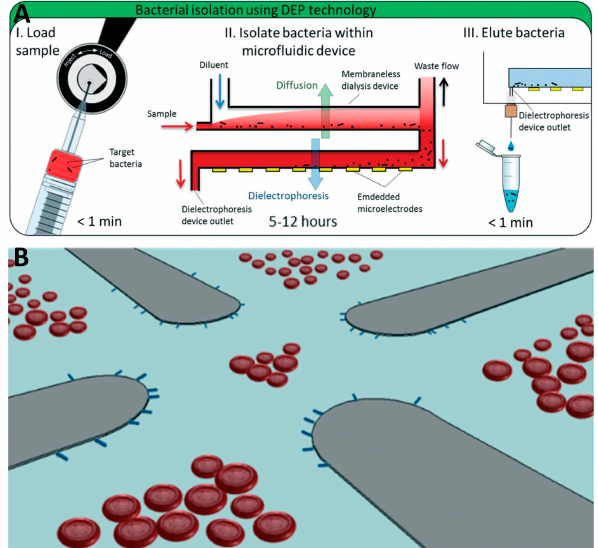
Figure 7. A device with quadrupole electrodes. ( A ) The principle of the device. ( B ) Schematic showing red blood cells (RBC) separation by quadrupole electrode configuration. Reproduced with permission from [65], © 2017 RSC.